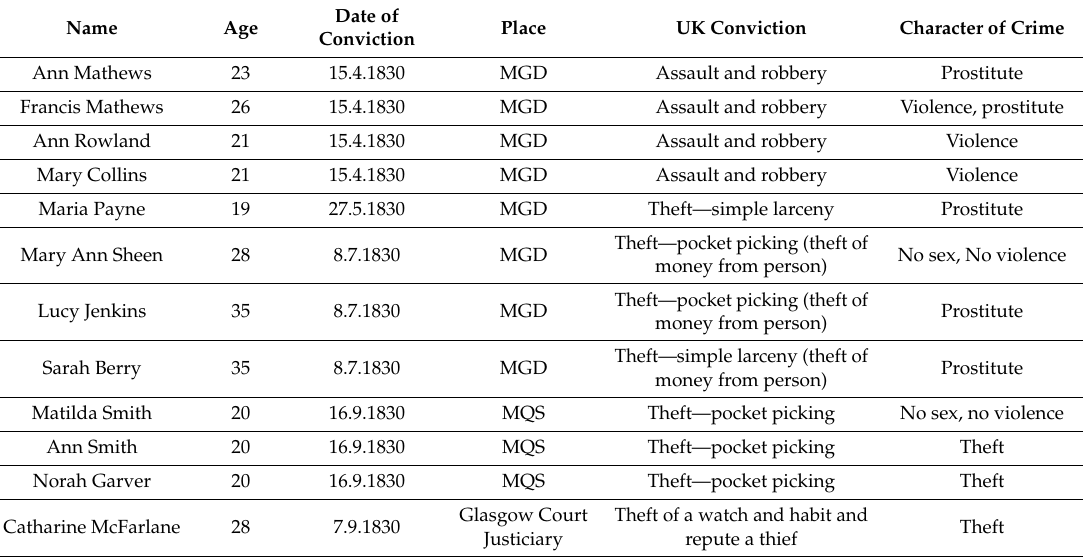
Table 2. Women convicted of ‘man robbery’ on 1830 Earl of